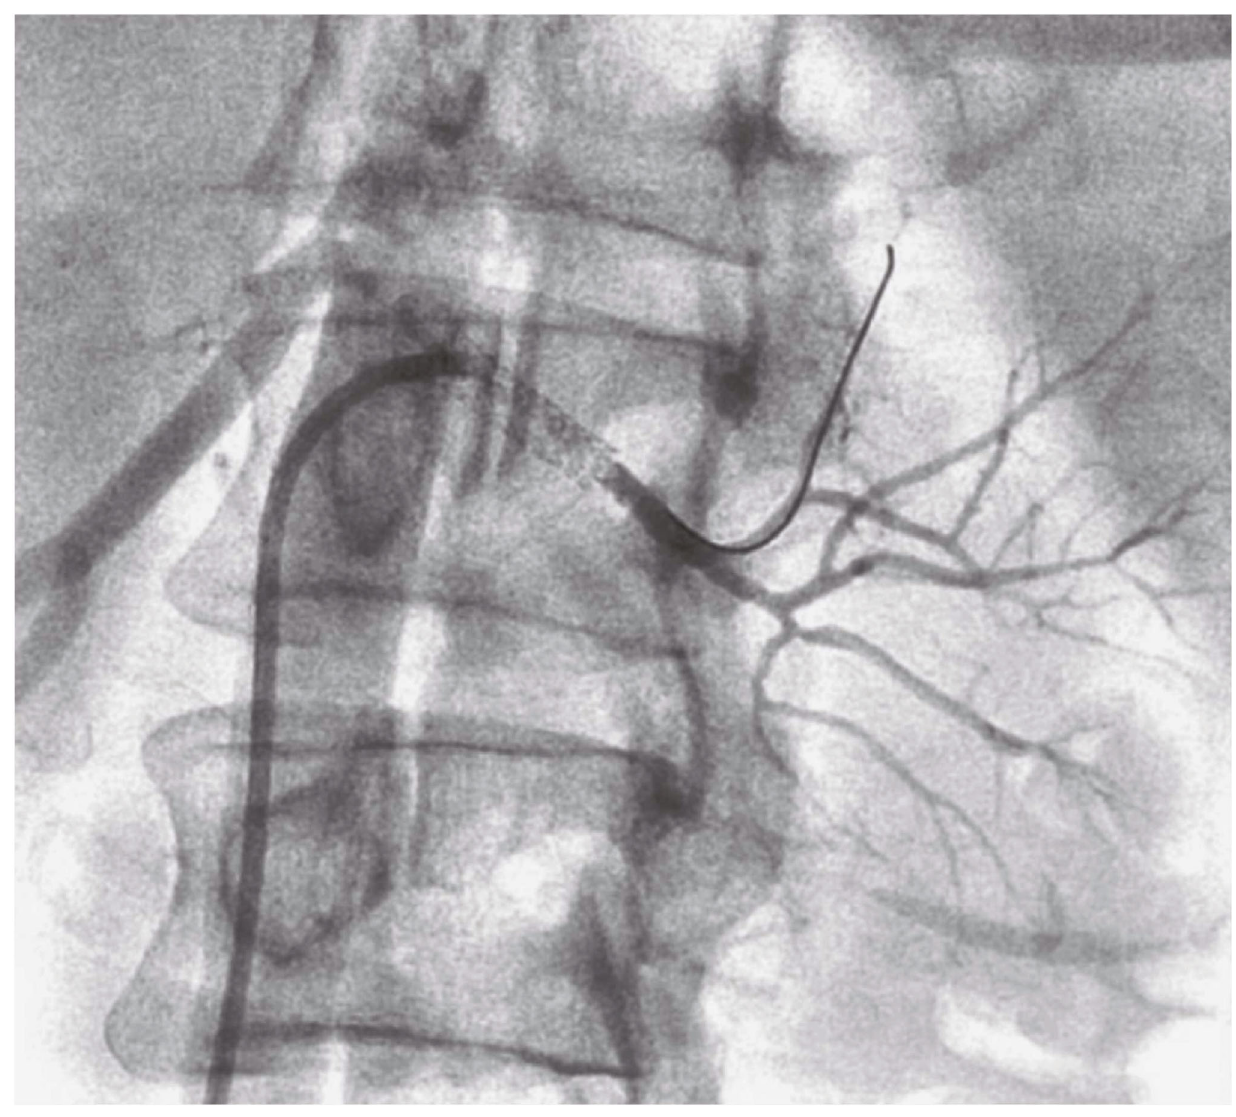
Figure 9: 8 months after atherectomy and stenting, angiography shows that the patient has severe instent restenosis with potential thrombus formation as